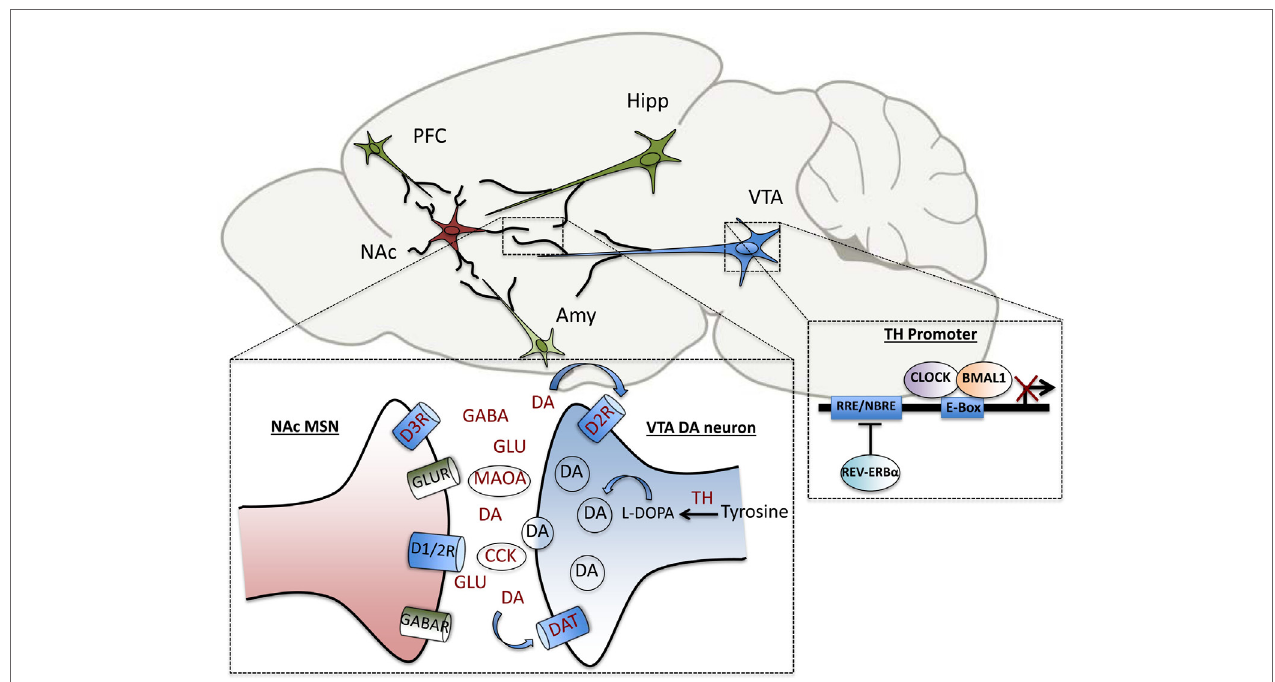
FiGURe 2 | elements of dopaminergic transmission are under direct circadian control. Within the VTA-NAc circuitry, clock genes regulate the transcription of several genes involved in the synthesis, uptake, transmission and degradation of dopamine, including tyrosine hydroxylase (TH), dopamine transporter (DAT), pre-synaptic dopamine type-2 receptor (D2R), dopamine type-3 receptor (D3R), monoamine oxidase A (MAOA), and cholecystokinin (CCK). Within the NAc, diurnal rhythms in levels of the neurotransmitters, dopamine, glutamate, and GABA have been measured as well. The transcription of TH is repressed by the circadian transcription factor, CLOCK, as well as the nuclear receptor, REV-ERB α , which bind to enhancer box (E-Box) and ROR response-element (RRE) sites in the promoter region,